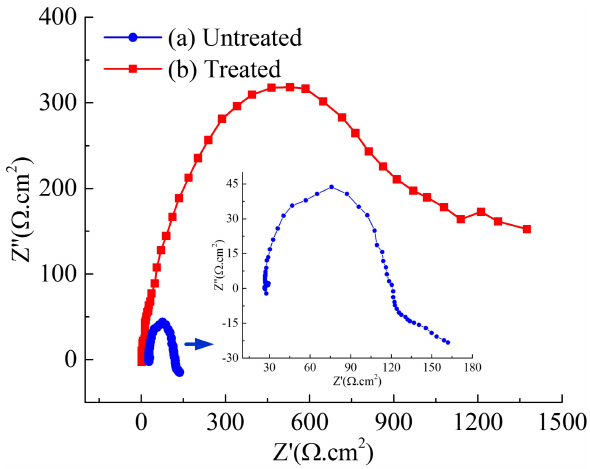
Figure 8. Nyquist plots of the ( a ) untreated and ( b ) treated Ti6Al4V surfaces in 3.5 wt % NaCl aqueous solution.